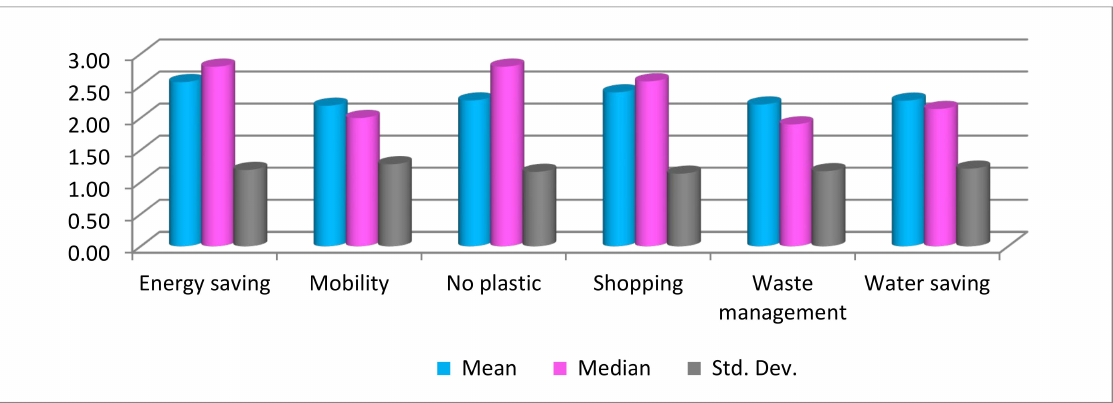
Figure 2. Most popular groups of practices.